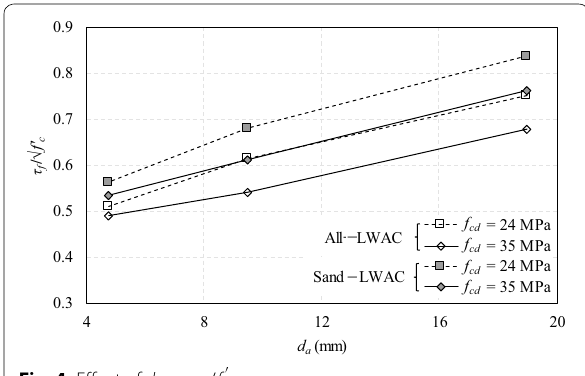
Fig. 4 Effect of d a on τ f / f ′ c